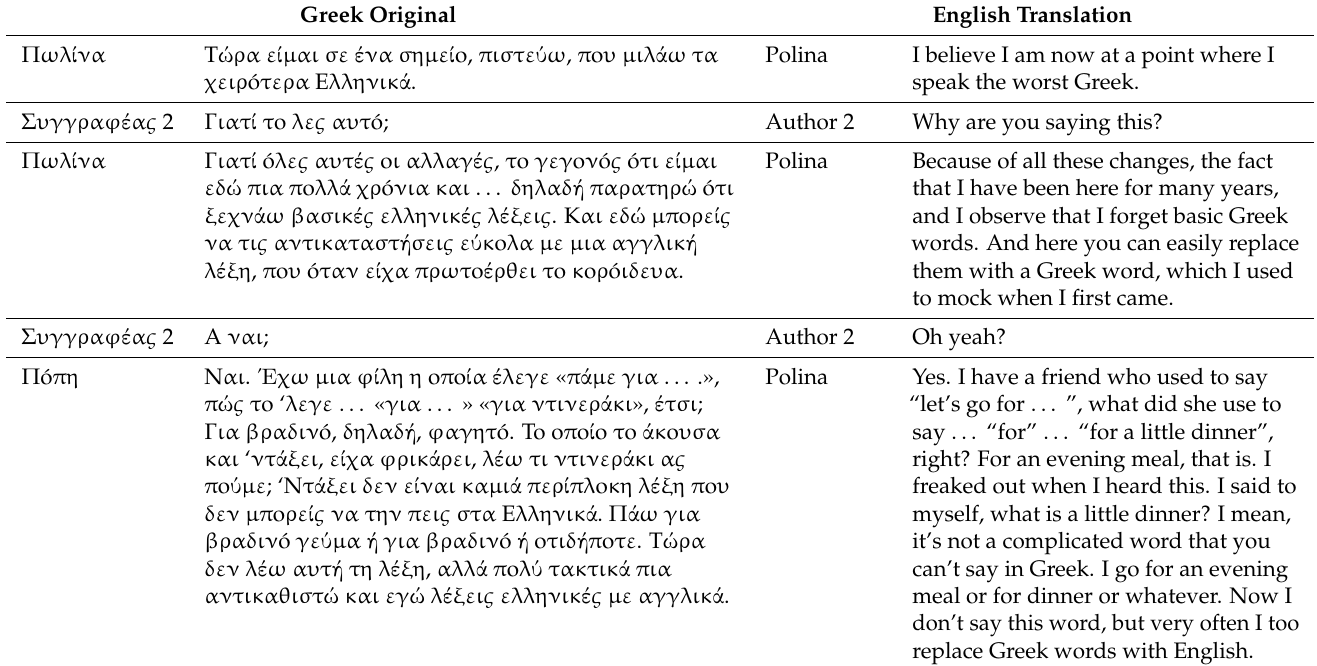
Table 2. “I speak the worst